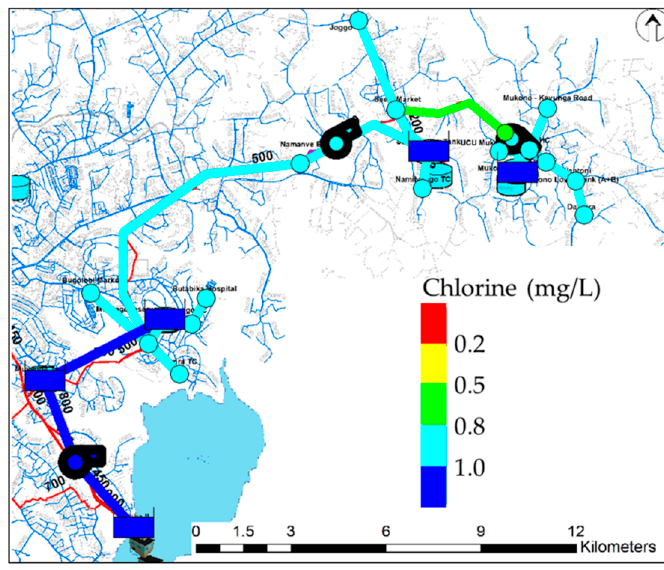
Figure 7. Kampala water distribution system and pipeline from Ggaba II to Mukono. The name of the numbered sites is shown on the Table 1. The overlaid colour of pipelines indicates free chlorine levels after 24 hours adding chlorine at reservoirs.